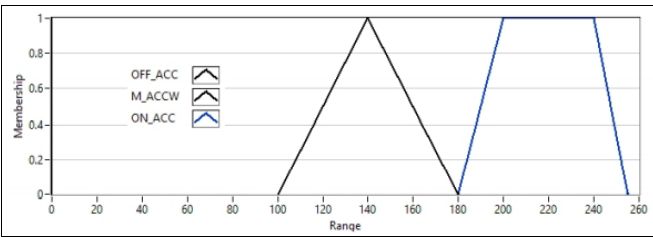
Figure 12: Graph of member functions of the Polar motion motor.